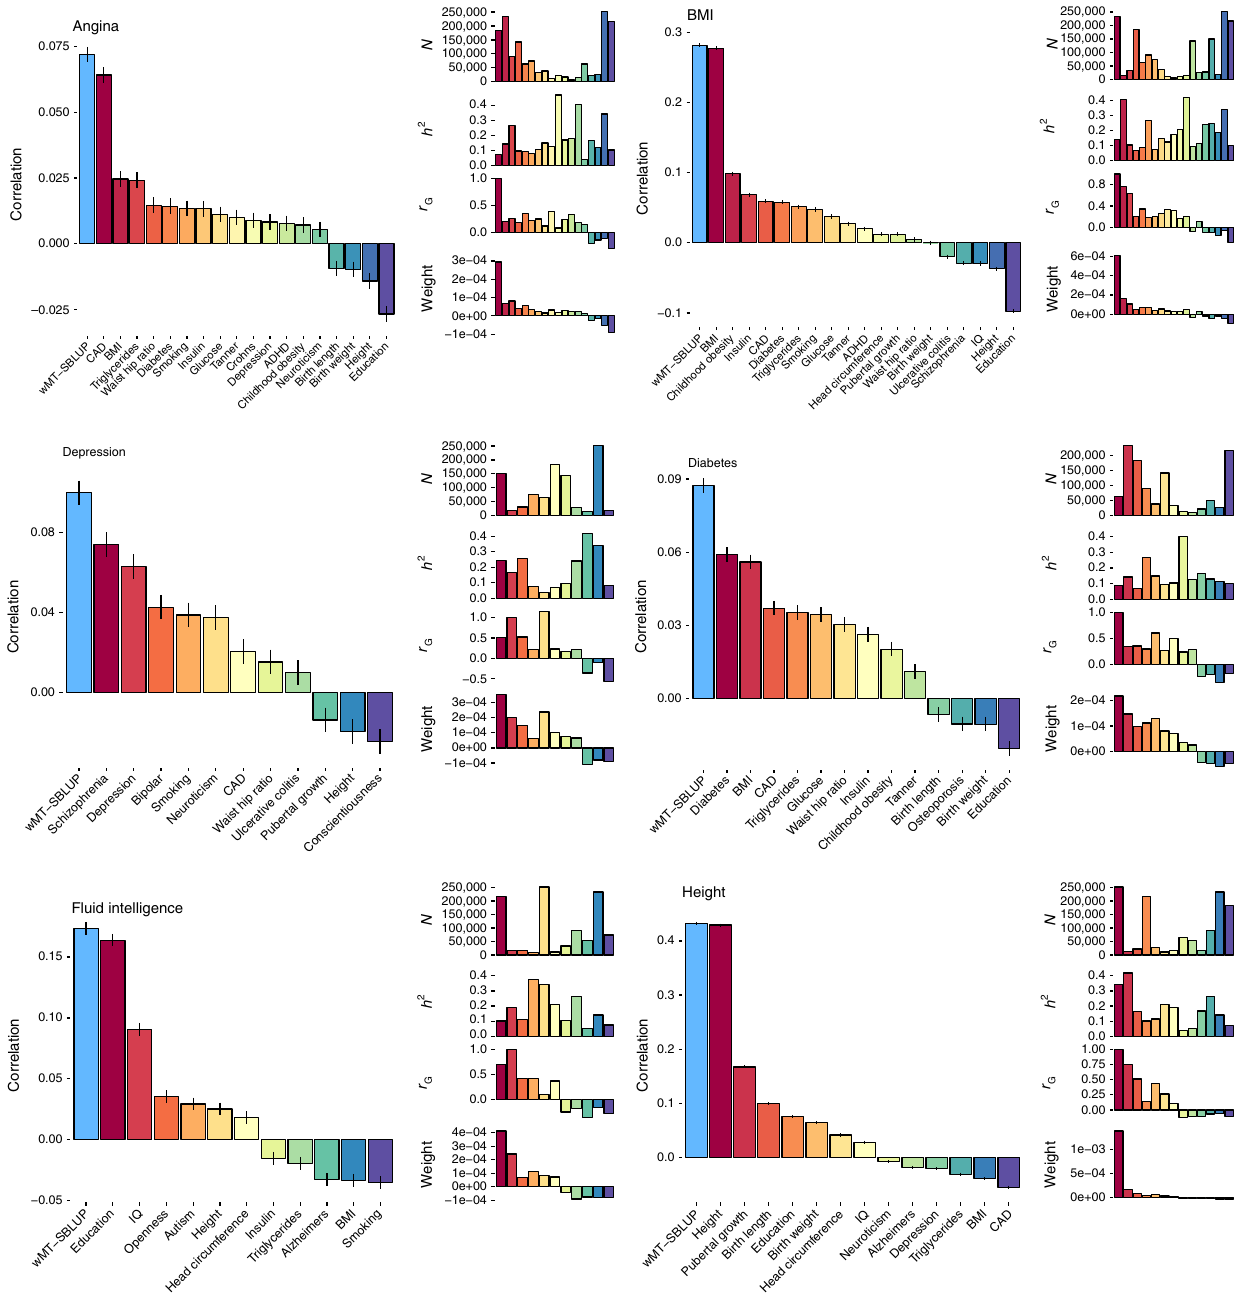
Fig. 4 Prediction accuracy for single-trait and multi-trait predictors in UK Biobank traits. Prediction accuracy for six traits in the UK Biobank for multi-trait predictors (light blue bars, wMT-SBLUP) and single-trait predictors (colourful bars on the right, SBLUP). Black bars show the correlation coef fi cient standard error. The multi-trait predictors for each trait are composed of all traits for which colourful bars are shown ( r G p -value < 0.05). Smaller bars on the right show, from top to bottom, sample size, SNP heritability, r G , and weights (given by Eq. (15)) for each where diag[ W ′ W ] has diagonal elements w j ′ w j and off-diagonal elements of zero. However, by analysing one SNP at a time, GWAS effect size estimates do not h i h i account for the covariance structure among SNPs and they are not unbiased in the ¼ ^ b 12 . BLUP of the SNP effects have the property E b j ^ b ¼ ^ b , sense that E b j ^ b are used in genomic prediction in animal and plant breeding 30 and more recently in human medical genetics, yielding improved prediction accuracy for a number of traits over genetic predictors created from OLS SNP estimates 16,17 . In a general form, BLUP solutions for b of Eq. (1) can be written using Henderson ’ s mixed Below, we describe how Eqs. (6) and (7) can be used to estimate BLUP SNP model equations 31 as: effects for a single trait and for multiple traits jointly from individual-level phenotype – genotype data. We then show how Eqs. (6) and (7) can be approximated to obtain BLUP SNP effects for single and multiple traits in the absence of individual-level data from publically available GWAS summary statistics and an independent reference sample.